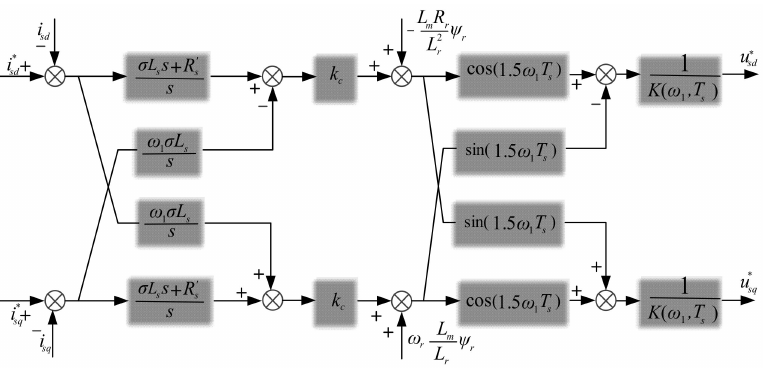
Figure 19. Scalar implementation loop for the proposed complex vector decoupling control.